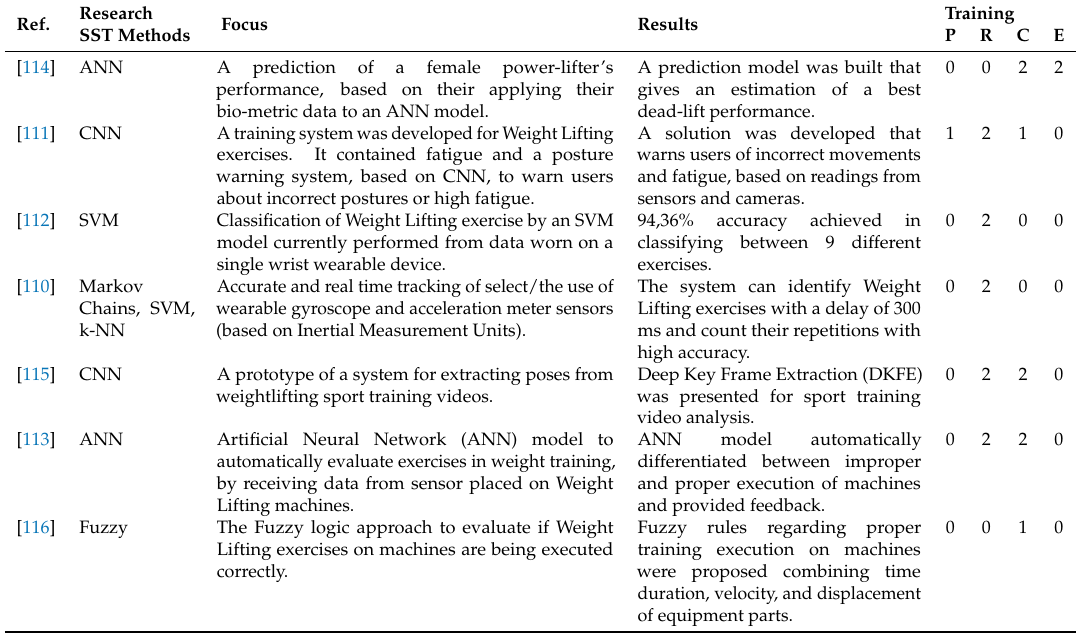
Table 17. Identified studies in the domain of weight